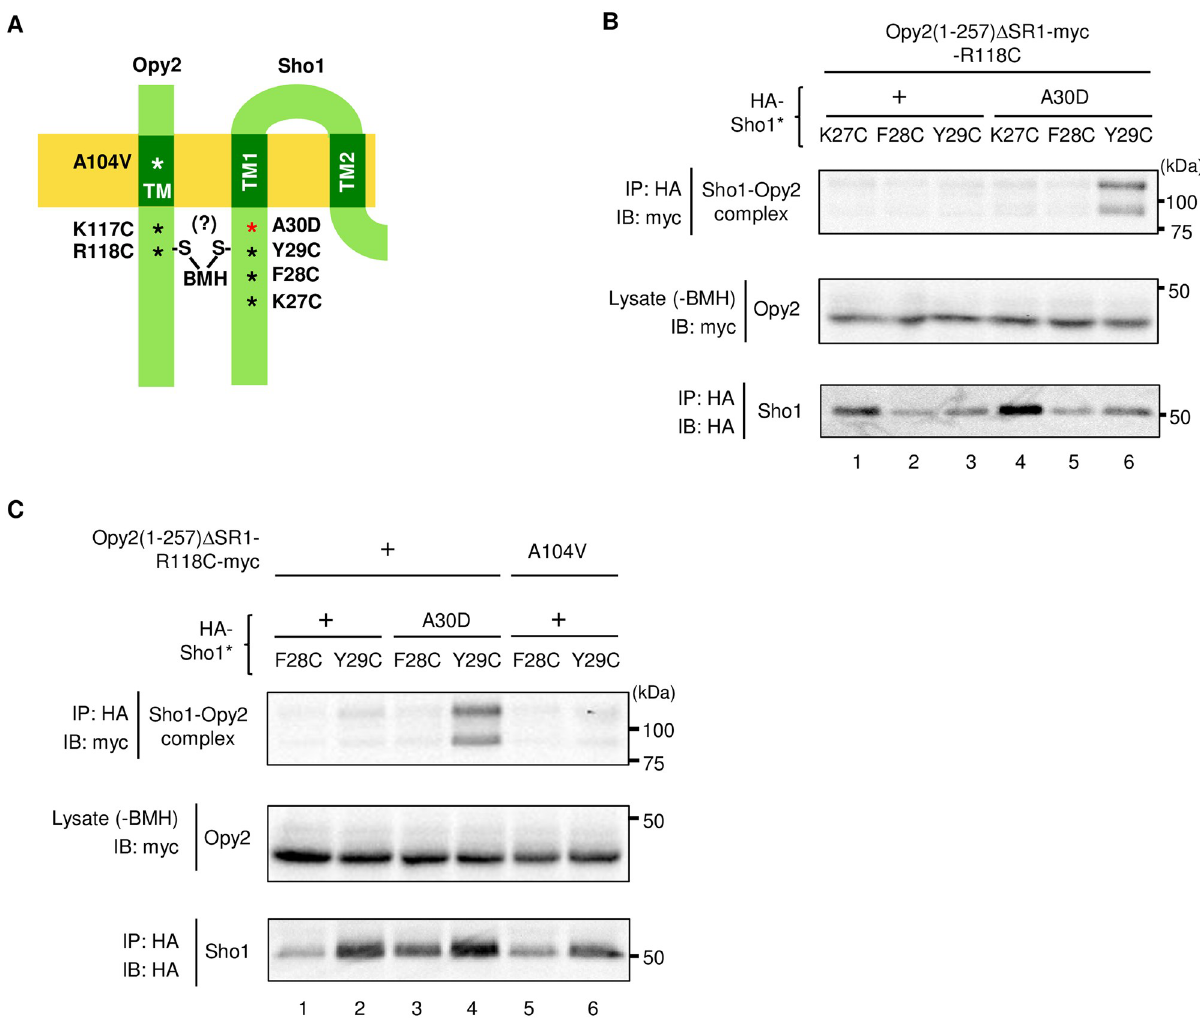
Fig 6. Close interaction between the Opy2 TM domain and the TM1 domain of Sho1. ( A ) Schematic model of the TM domains of Opy2 and Sho1 that interact each other. Numbers indicate amino acid positions. Asterisks indicate the positions of relevant mutations in Opy2 and Sho1. ( B, C ) Chemical crosslinking between Sho1 and Opy2. Expression plasmids ( GAL1 promoter) for the indicated mutant derivatives of HA-Sho1 � and either Opy2(1–257) Δ SR1-myc-R118C or A104V R118C were co-transfected into KY590-1. After induction by 2% galactose for 2 h, intact cells were treated with 0.4 mM BMH at 30 ˚C for 5 min. For the control samples to monitor the Opy2-myc expression levels, BMH treatment was omitted (-BMH)). Cell lysates were prepared with buffer A containing 0.2% Triton X-100. HA-Sho1 � was immunoprecipitated, and the covalently bound Sho1-Opy2 complex was detected by